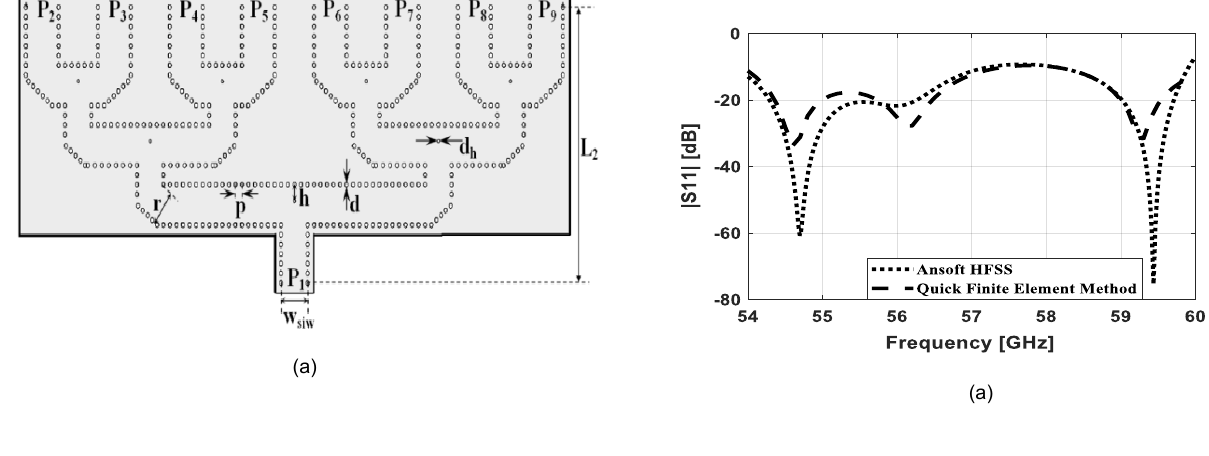
FIGURE 8. The 1 × 8 power divider structure in 3D Figure 8 represents the optimized two-way SIW power divider in 3D form. The comparison of the reflection and transmission coefficient results of the V-band of the power divider shown in Figure 7 in the frequency range of 54-60 GHz by the quick finite element method and Ansoft HFSS software is shown in Figure 9